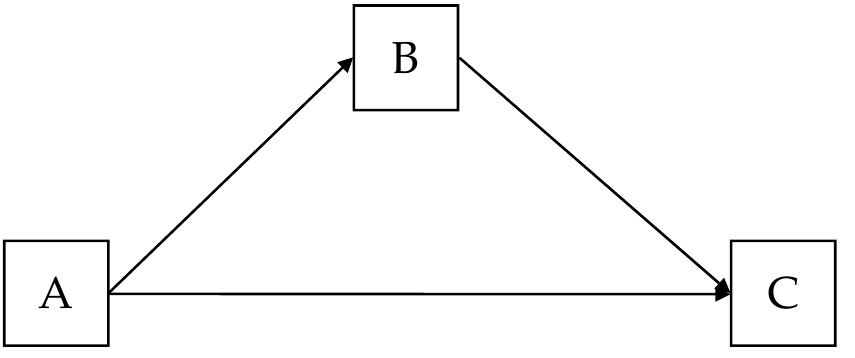
Figure 1. Simplified Partial Mediation Model. This figure depicts a partial mediation model where A and C are directly related, but the effect is also partially mediated by B.